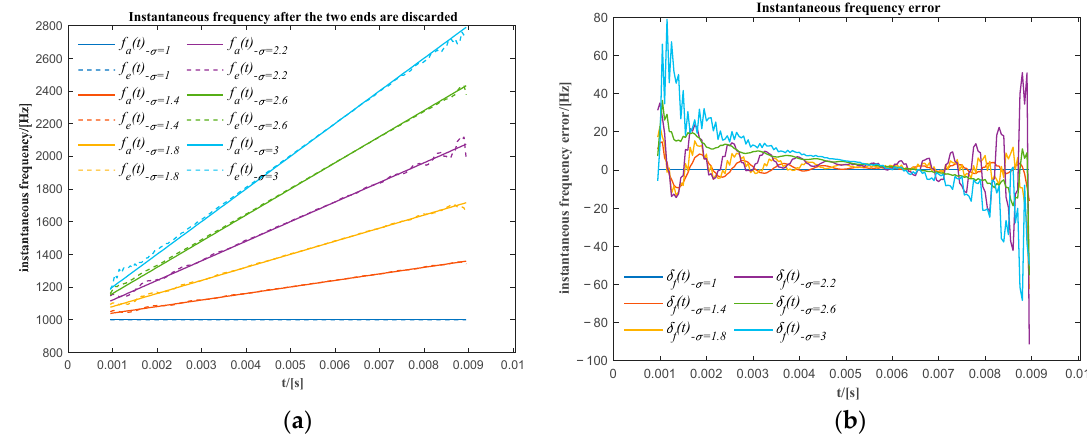
Figure 7. The maximum unwrapped phase error for different relative frequency ratios.